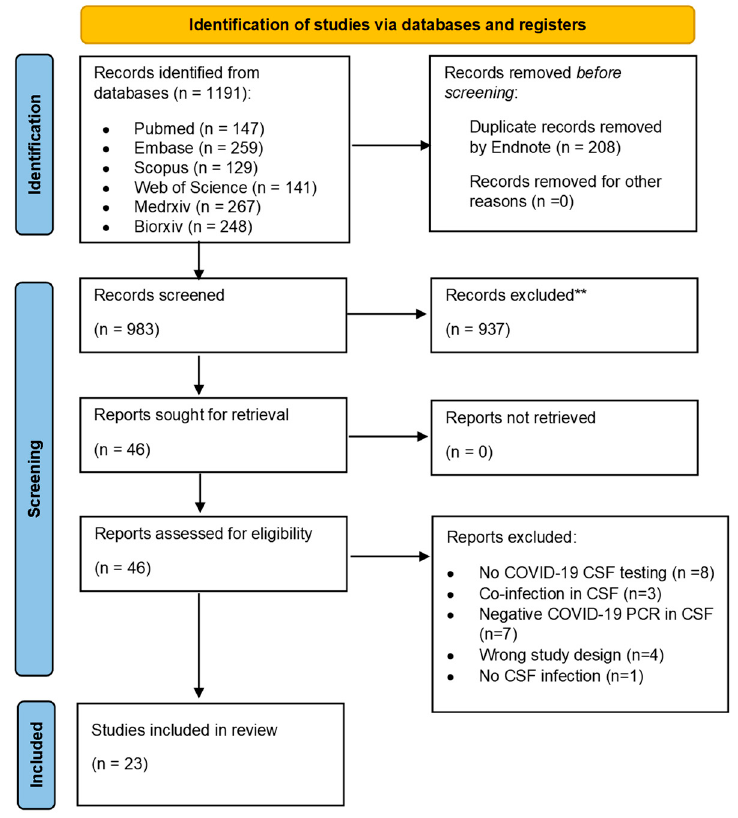
Figure 1. PRISMA flow-chart of the study selection process.